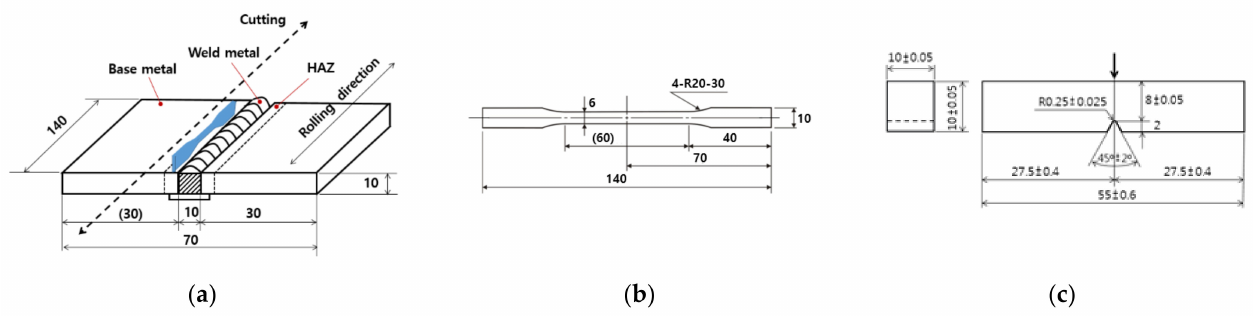
Figure 2. Plate welding and production of specimens. ( a ) Plate welding; ( b ) tensile specimen, thickness 5 mm; ( c ) Charpy impact